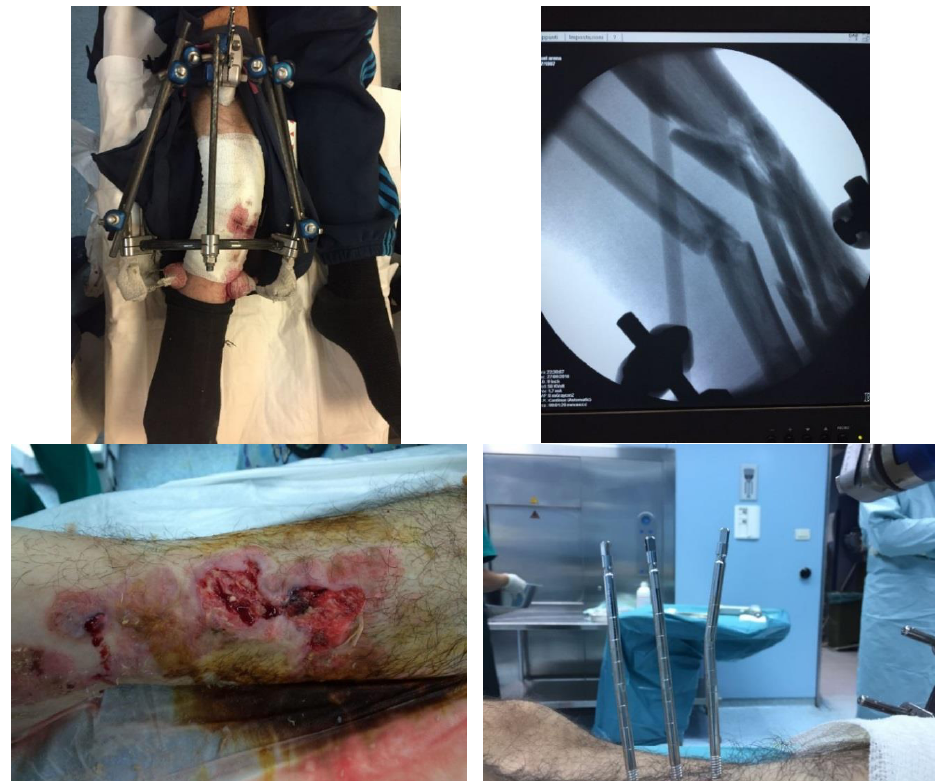
Figure 5. Images of the fracture, soft tissue, and external fixation implant following the new motorcycle accident three months after the first one.